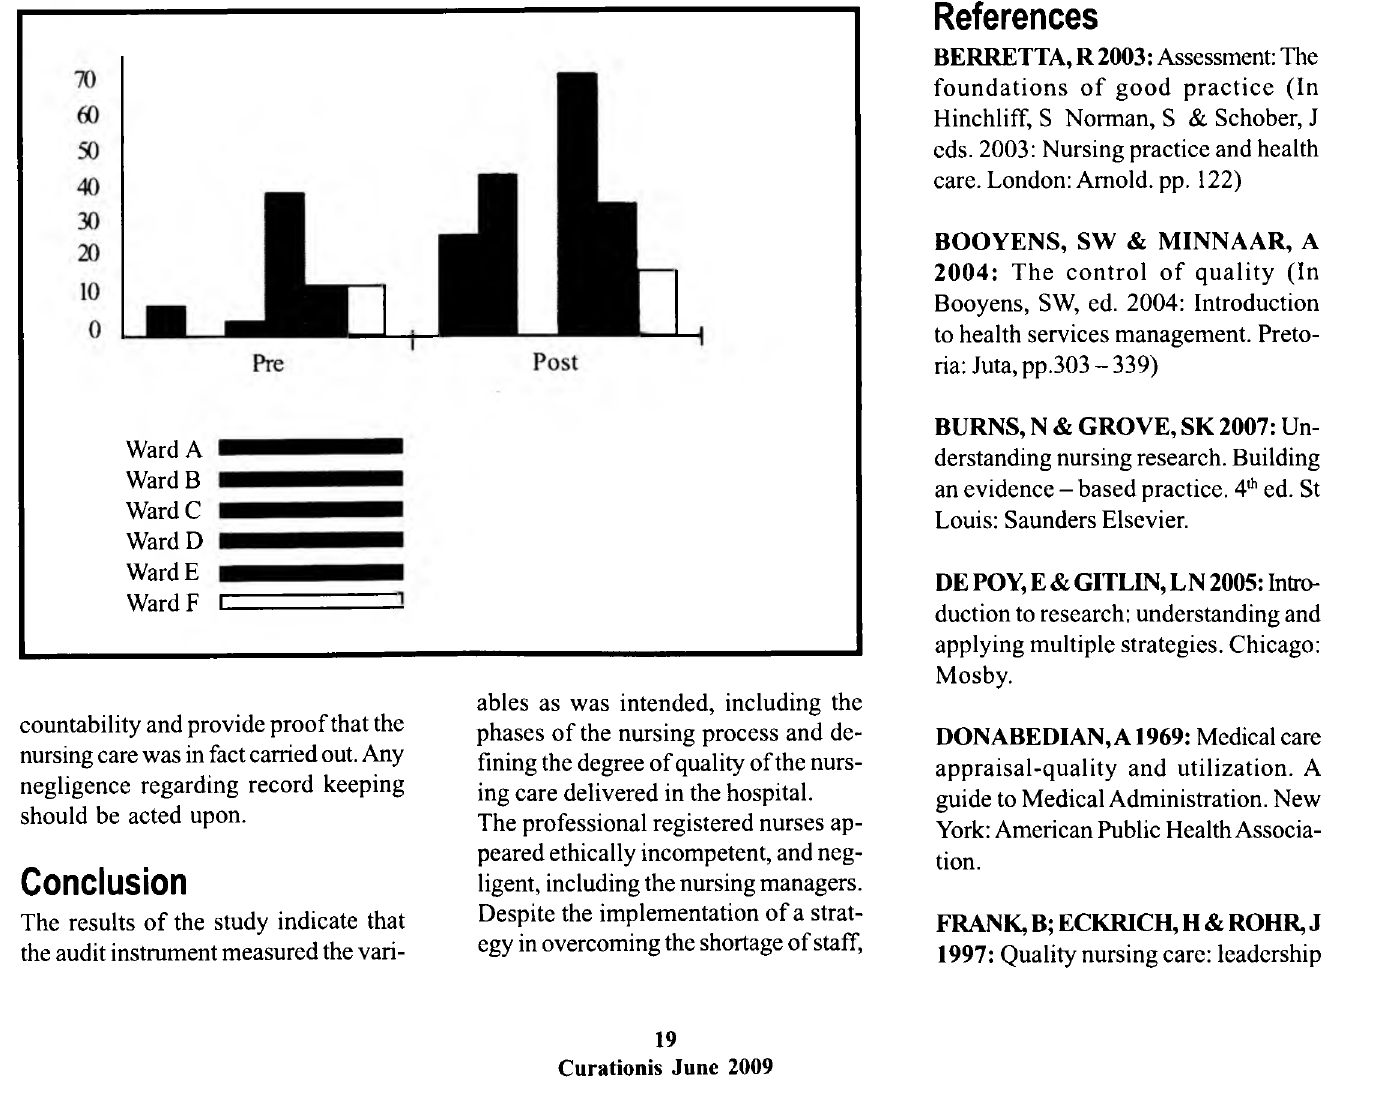
Figure 10: Relatives informed about death, transfer or discharge informed about death, transfer or